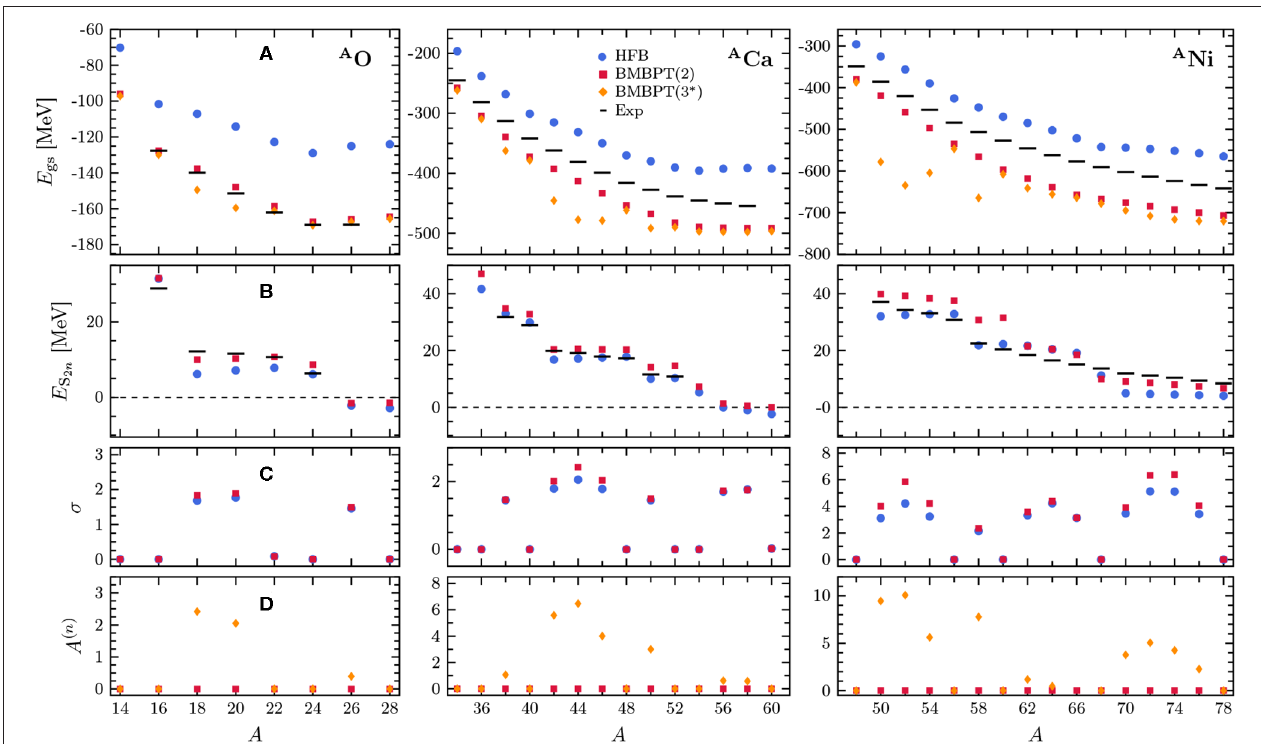
FIGURE 9 | BMBPT systematics along O, Ca, and Ni isotopic chains: (A) absolute binding energies, (B) two-neutron separation energies, (C) neutron-number dispersion, and (D) perturbative correction to the average neutron number. The employed Hamiltonian is defined in section 3. Plot markers correspond to HFB ( l ), second-order BMBPT ( (cid:4) ), and third-order BMBPT without particle-number adjustment ( (cid:4) ). All calculations are performed using 13 oscillator shells and an oscillator frequency of ¯ h ω = 20MeV. The SRG parameter is set to α = 0.08fm 4 . Reproduced from Tichai et al. [ 37] under the Creative Commons CC-BY license.